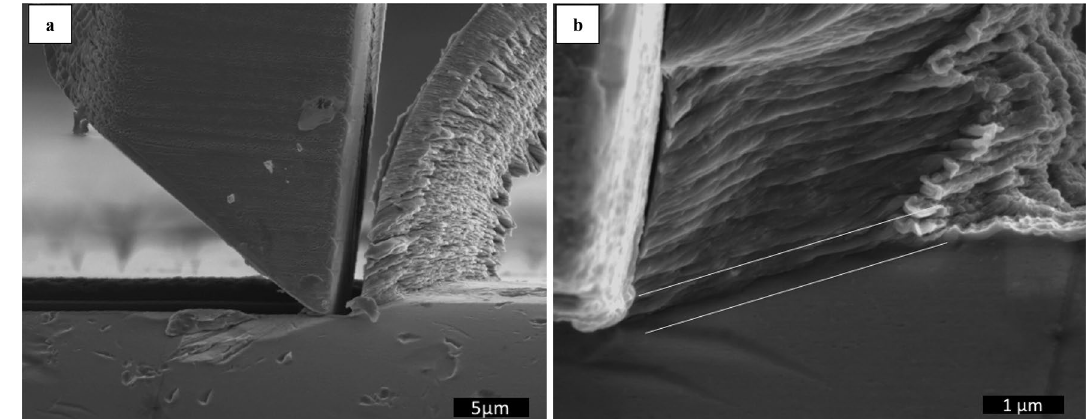
Figure 2. ( a ) Lateral overview of the system workpiece-chip-tool. ( b ) Steady state shape of fully developed PSZ, PSZ is marked by white